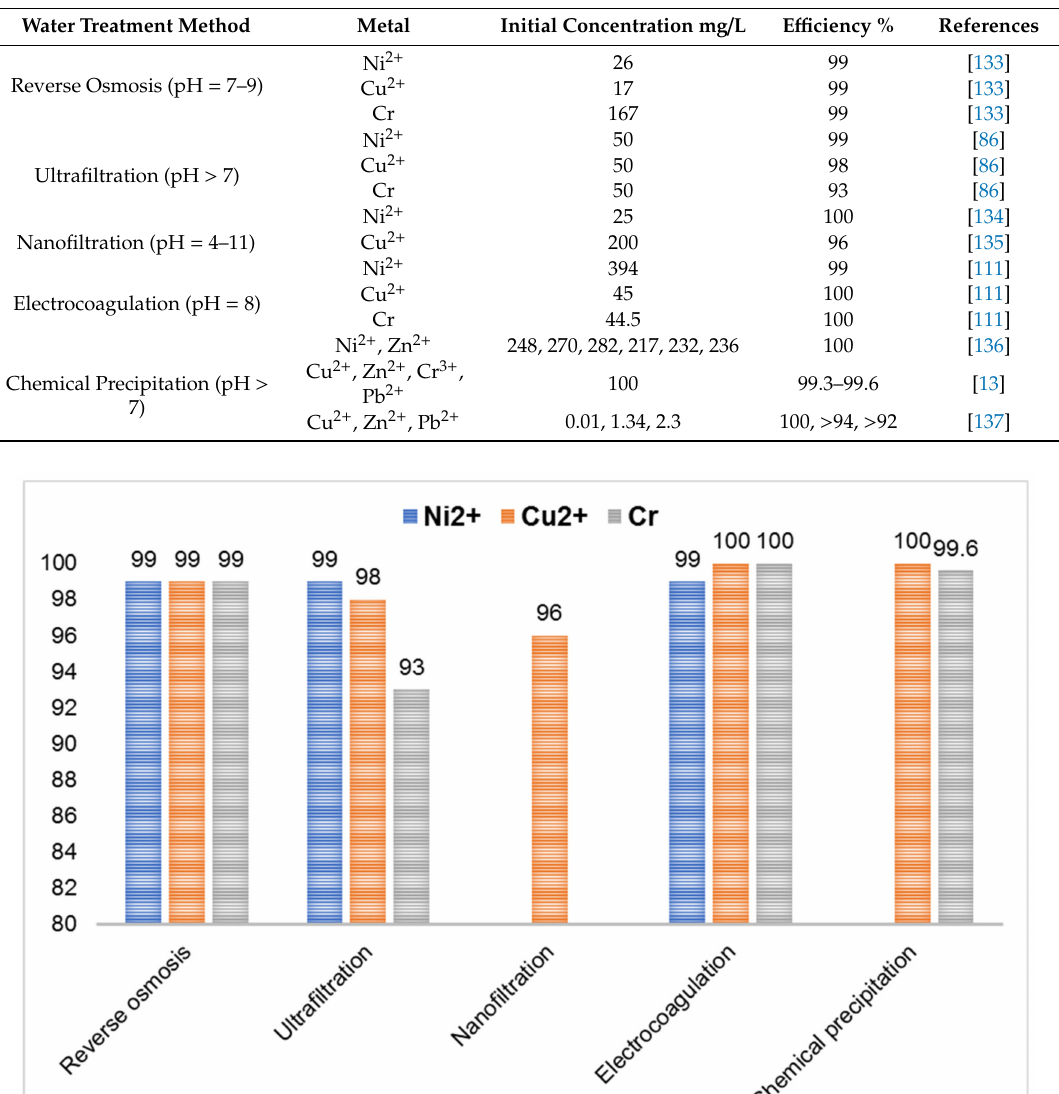
Table 7. Comparison of the removal e ffi ciency of heavy metal ions by di ff erent water treatments.